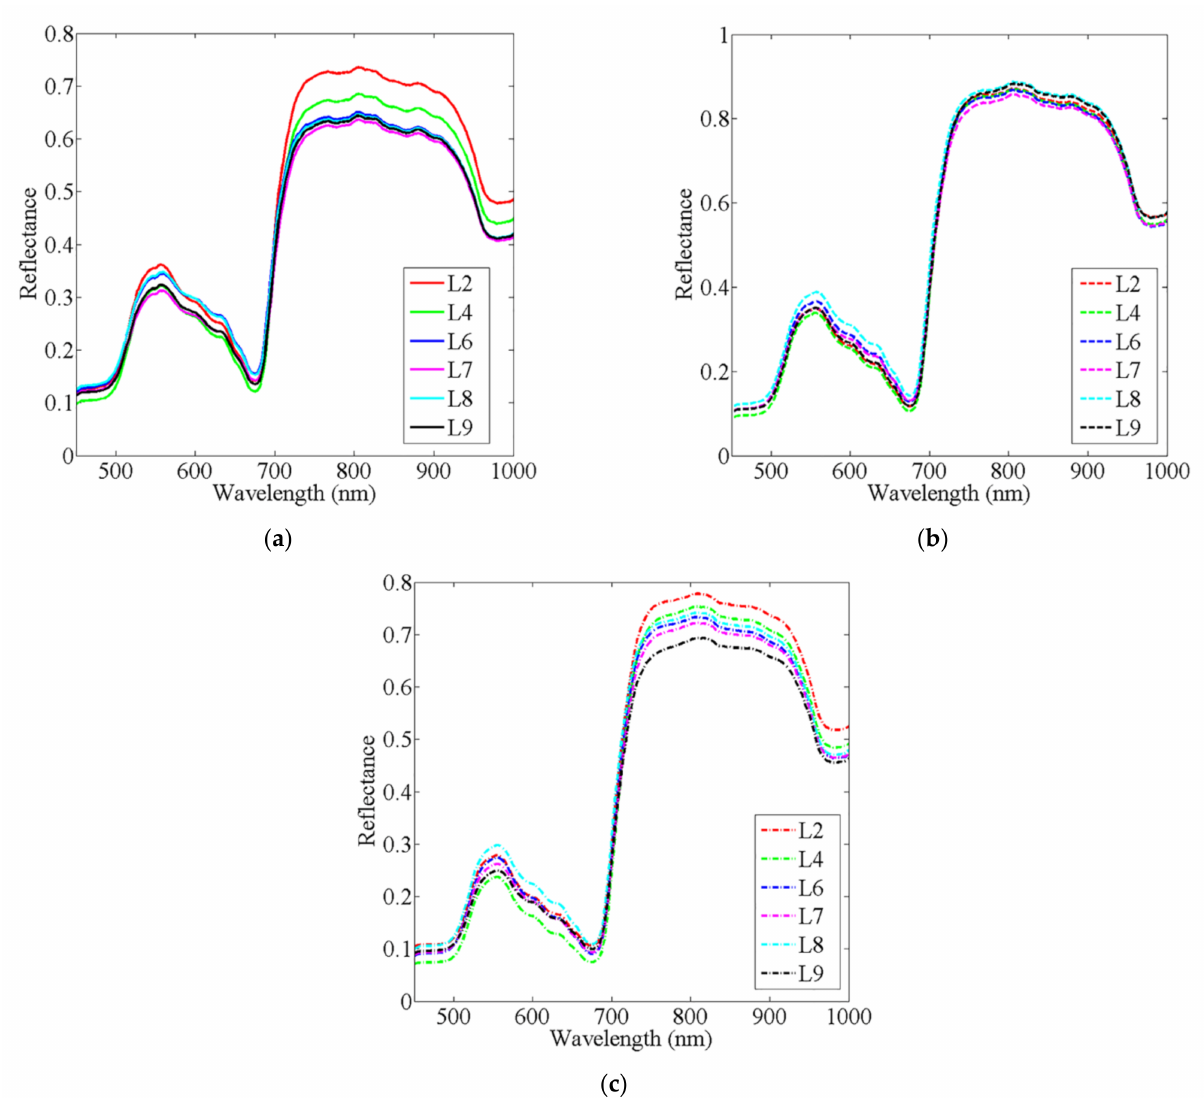
Figure 4. The average spectra of ( a ) pedicel zone; ( b ) middle zone and ( c ) apex zone in the six maturity